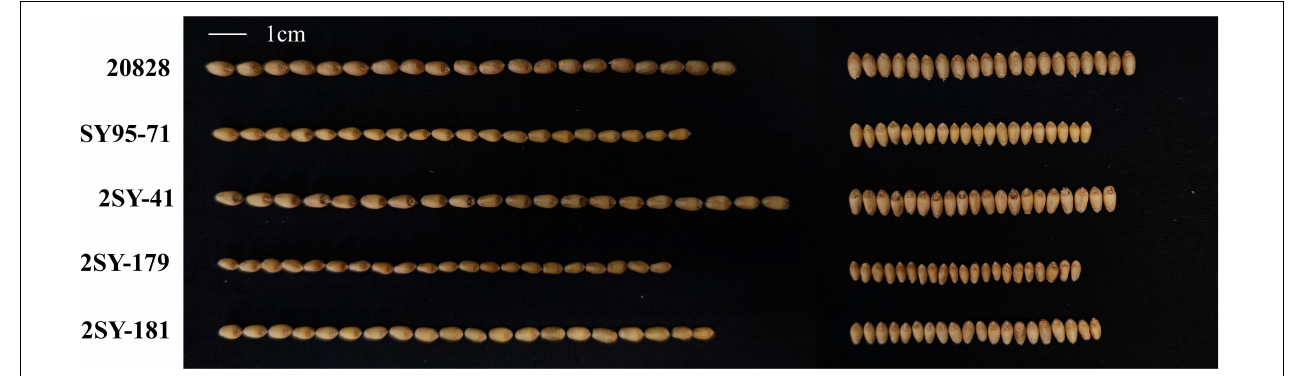
FIGURE 1 | Kernel phenotypes of the parent “20828,” “SY95-71,” and partial RILs. The white line represents the scale = 1 cm.